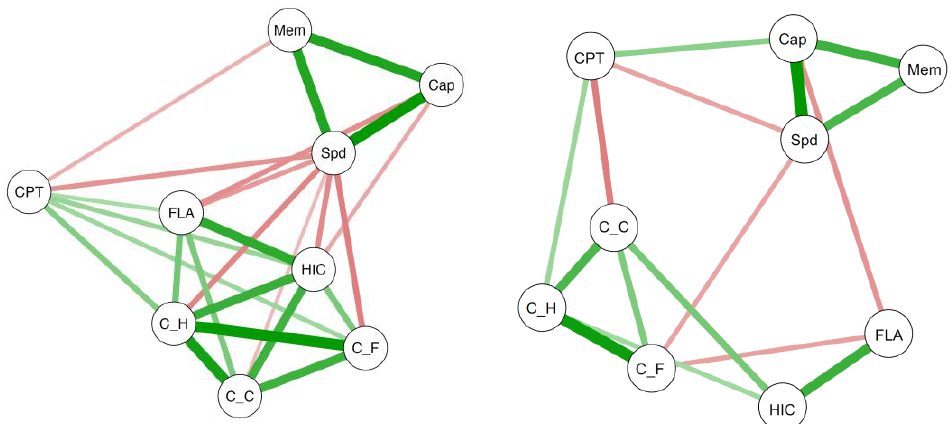
Figure 6. Network analysis based on Pearson correlations (left panel) and partial correlations (right panel) between three aspects of psychometric intelligence (BIS-Capacity, BIS-Speed, and BIS-Memory), sustained attention, selective attention, and speed of decision making, as well as three variables representing basic speed in the three experimental tasks. Green and red edges indicate positive and negative relationships, respectively. Only the (partial) correlations that reached statistical significance ( p < .05) are presented. Abbreviations: Cap = BIS-Capacity; Mem = BIS-Memory; Spd = BIS-Speed; CPT = factor scores of the latent variable with increasing factor loadings from the continuous performance test (sustained attention); FLA = factor scores of the latent variable with increasing factor loadings from the flanker task (selective attention); HIC = factor scores of the latent variable with increasing factor loadings from the Hick task (speed of decision making); C_C, C_F and C_H = factor scores of the latent variables with constant factor loadings from the CPT (C_C), the flanker task (C_F), and the Hick task (C_H).